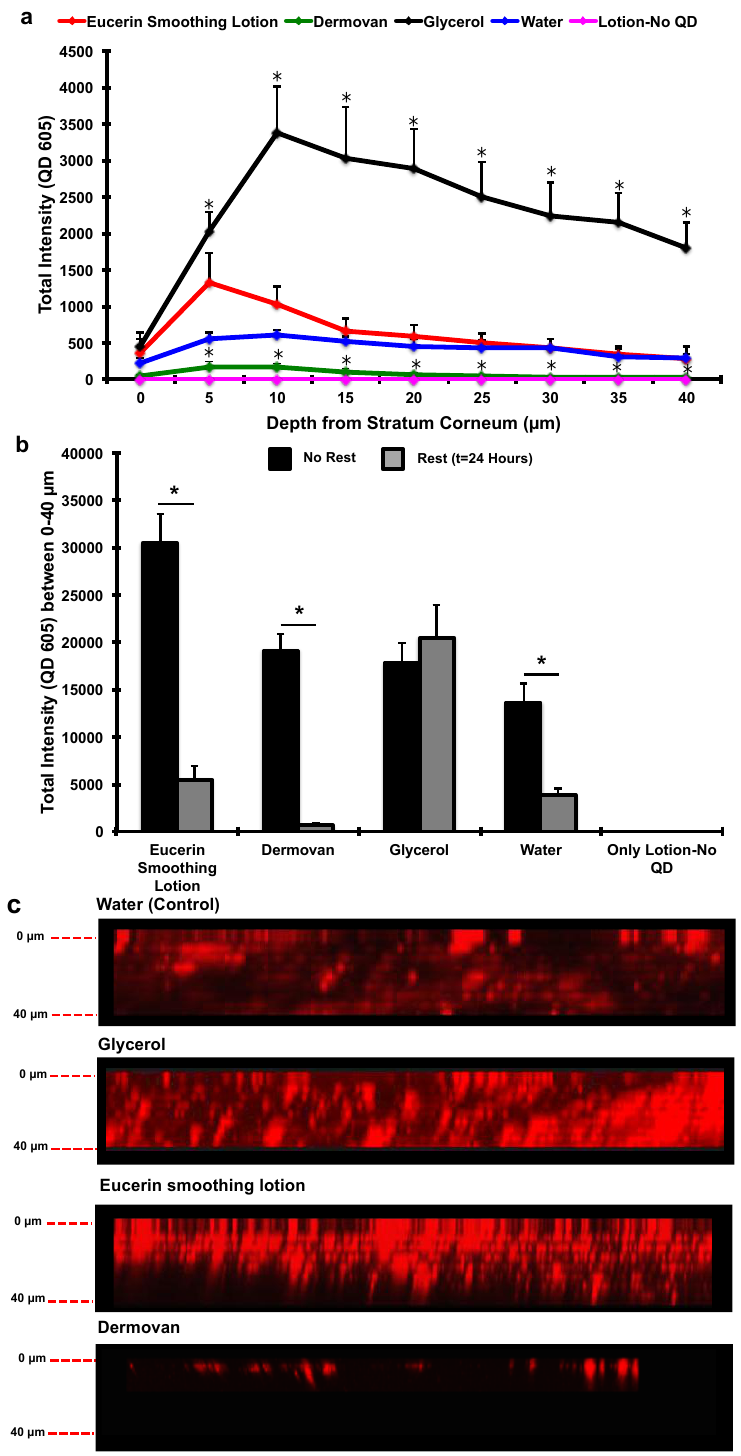
Figure 4. Ex vivo skin processing prior to QD application alters QD penetration in human skin. ( a ) QD presence in human skin rested 24 h prior to QD application was quantified using CLSM. A significant increase in QD presence was observed in the glycerol group compared to water. All other vehicles exhibited QD penetration trends similar to the water; Mean ± SEM ( N = 4, n = 3). * p < 0.05 vs. water; ( b ) comparison of integrated QD fluorescence intensity in human skin; rest vs. no rest. A significant decrease in QD presence was observed in the Eucerin smoothing lotion (5.5-fold), Dermovan (29.2-fold) and water (3.6-fold) rested skin groups compared to non-rested groups. No significant differences were observed in the glycerol group; mean ± SEM ( N = 4, n = 3). * p < 0.05; ( c ) side profile view of rested human skin showing lower presence of QDs in the Eucerin Smoothing Lotion and Dermovan treatment group compared to human skin that is not